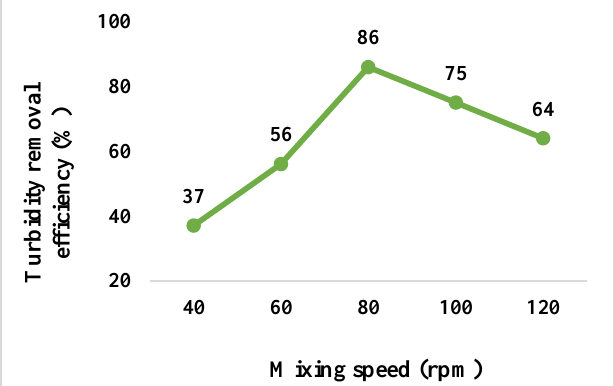
Fig. 5. Effect of mixing speed (rpm) on turbidity removal